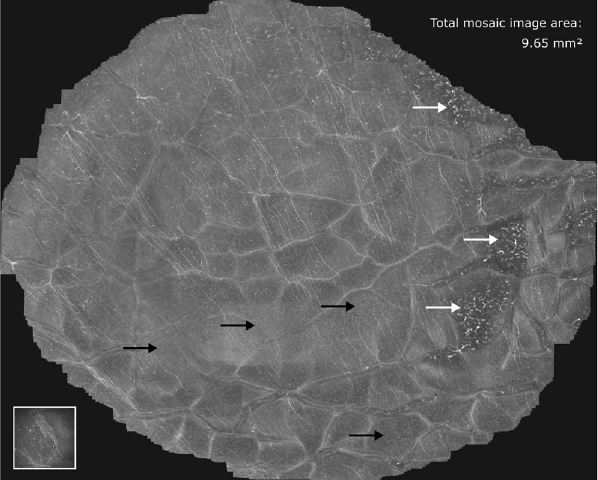
Figure 1. SNP mosaic image created using the EyeGuidance system without focus adjustments, as described by Allgeier et al . 21 . Several image areas show epithelium (black arrows) or stroma tissue (white arrows). The bottom left inset represents the size of a single CCM image (0.4 × 0.4 mm²) from the recorded